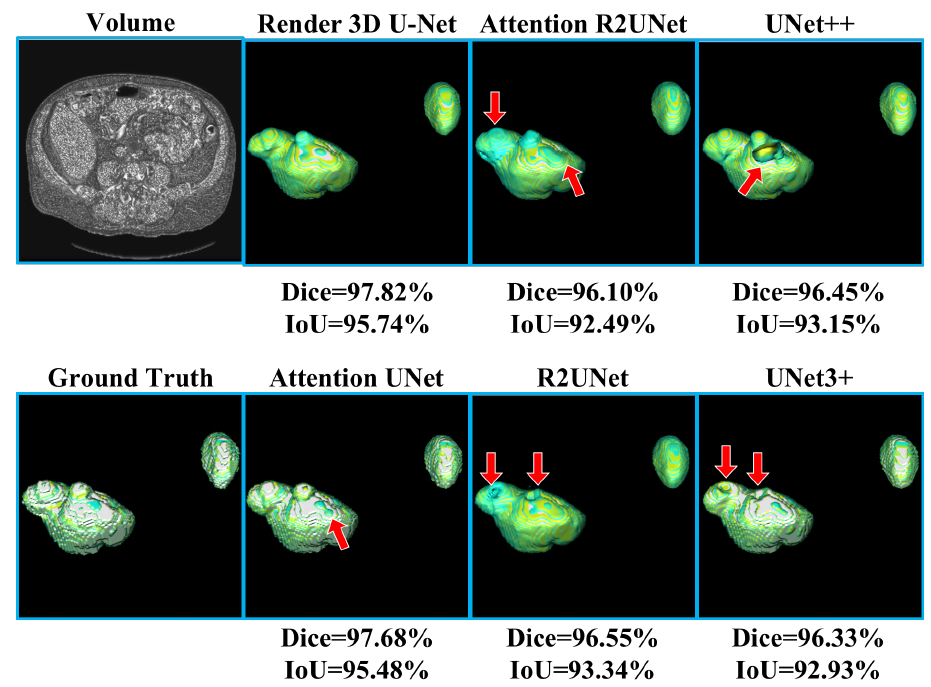
Figure 9. Comparison of model outputs and ground truth, where the prediction-missed areas are highlighted with red arrows: the prediction of Render 3D U-Net is generated under the point-sampling method and false positive classification